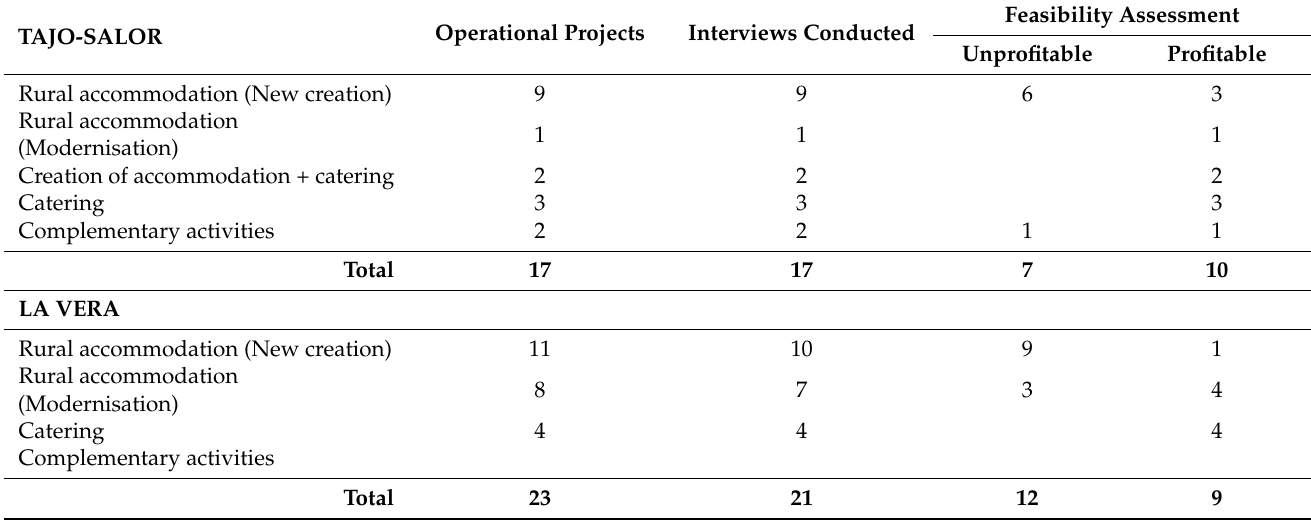
Table 9. Assessment of the viability of tourism projects in Tajo-Salor and La Vera